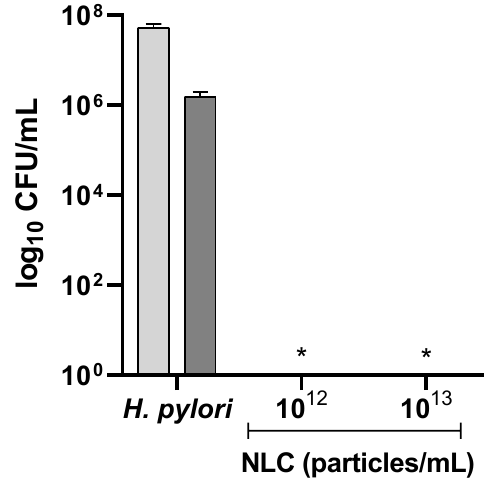
Figure 6. Antibacterial performance of increasing concentrations of NLC60 M against H. pylori J99 in rod and coccoid morphologies. Assay was performed in PBS over 6 h of incubation. Data are expressed as means ± standard deviation. Statistical analysis was performed against the control (bacteria without NLC) using Tukey’s multiple comparisons test. * Both morphologies ( p < 0.0001). H. pylori was grown in rod- and coccoid-shape and both initial cultures were adjusted